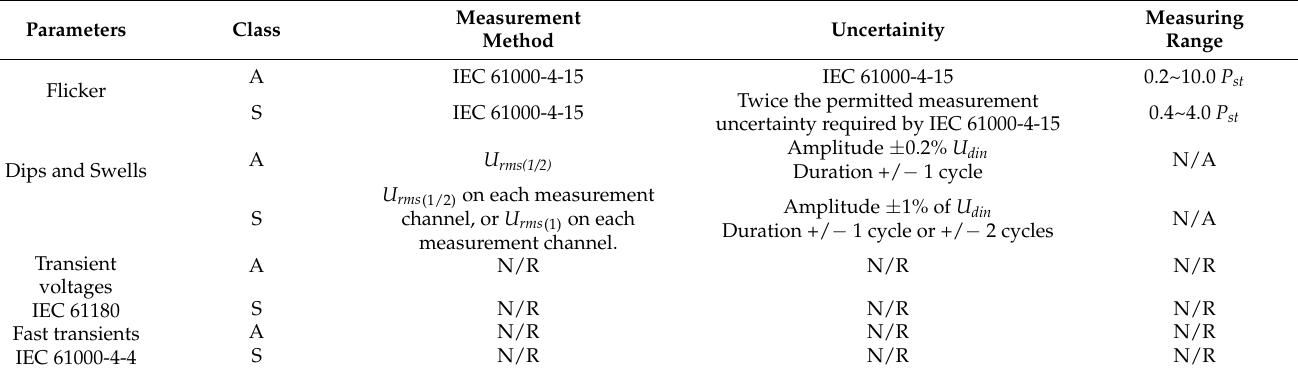
Table 3. Fragment of the power quality parameters according to IEC-61000-4-30 standard